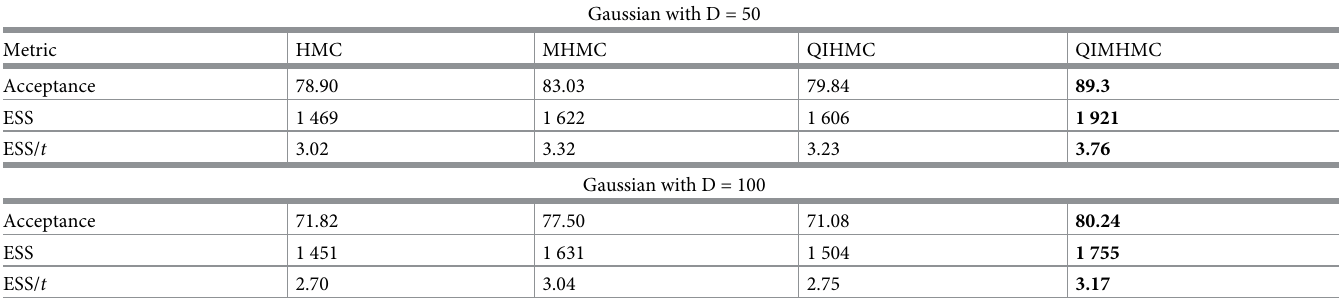
Table 3. Multivariate Gaussian distribution results averaged over 10 runs. The time t is in seconds. The values in bold indicate that the particular method outperforms the other methods on that specific metric.